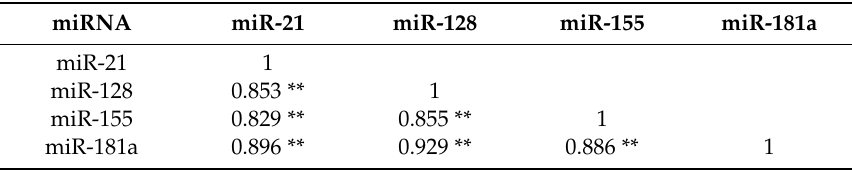
Table 2. Spearman’s correlation among